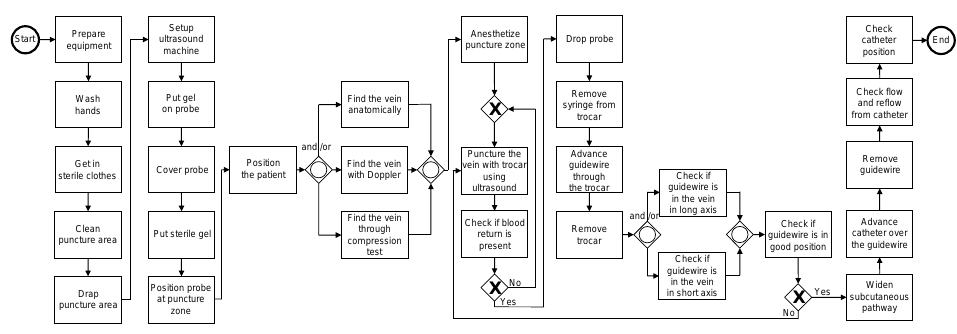
Figure 2. Surgical Process Model depicting the central venous catheter installation procedure, particularly the activities, decision points, and paths involved